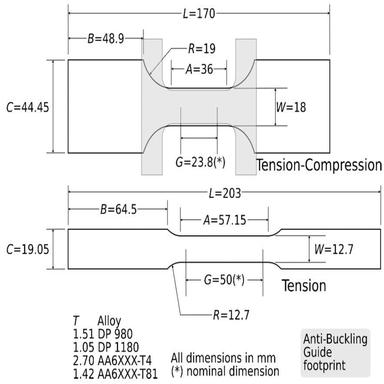
Test specimen nominal dimensions for tension and tension-compression tests.